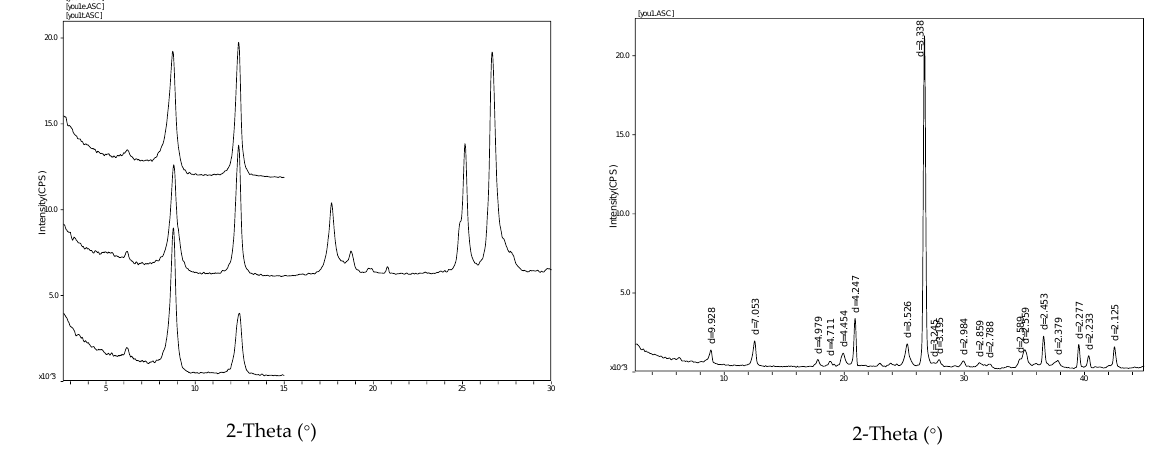
Figure 4. Mineral analysis spectrogram.